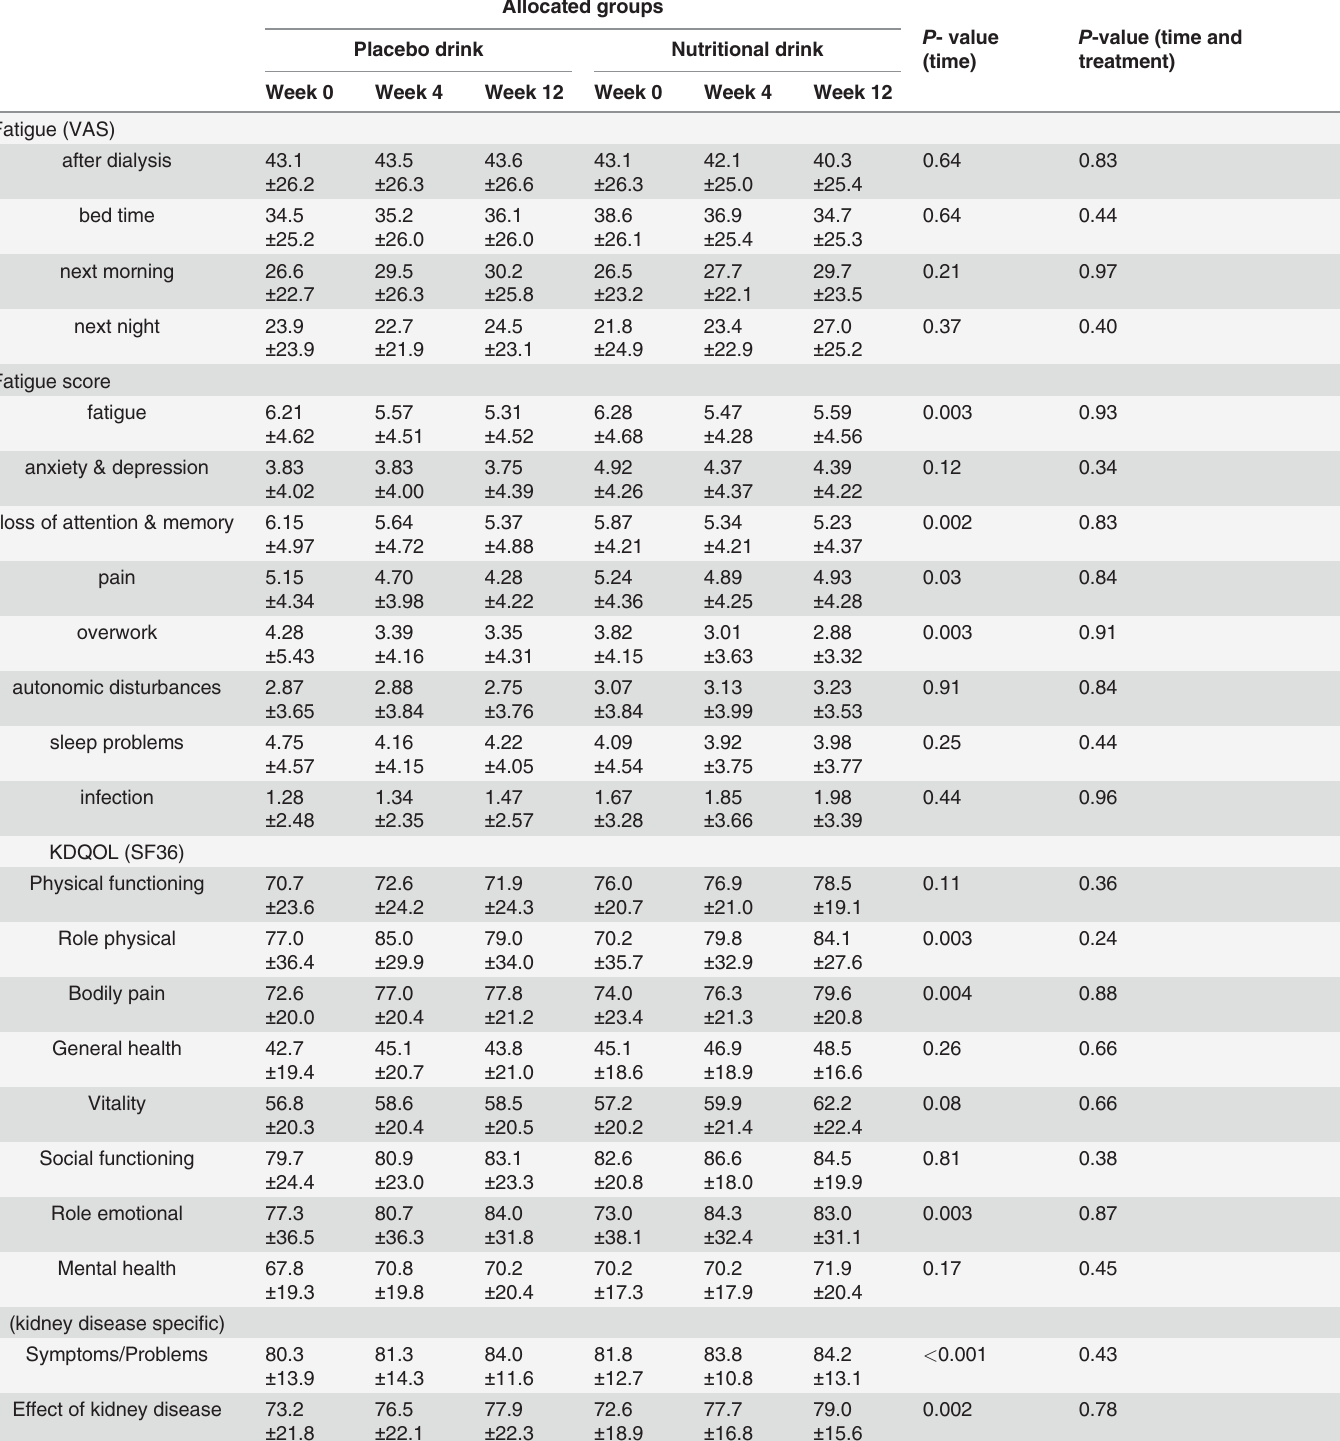
Table 2. Changes in fatigue and QOL scores throughout the clinical trial.